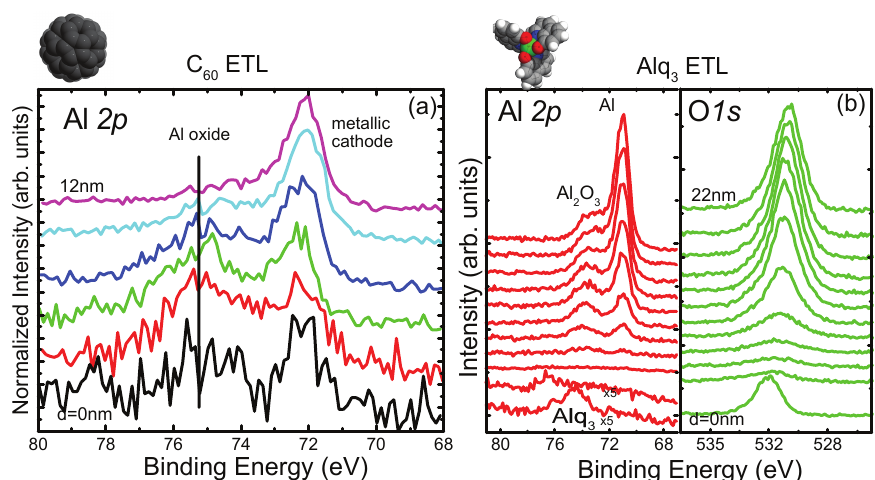
Figure 6. ( a ) XPS Al 2p core level for the sputter profile through the thickness of the LiF layer for peeled Al/10 nm LiF cathodes on C 60 based OLEDs, showing the evolution of the chemisorbed Al. Reproduced from Ref. [34] with permission of The Royal Society of Chemistry. ( b ) XPS depth profile on the Al/LiF side of peeled off interface with 20 nm LiF layer. The evolution of the Al 2p , and O 1s core level features is shown as a function of the distance from the interface. The presence of an Al oxide at the Al/LiF interface suggests diffusion of O through pinholes in the Al films. Such O diffusion ends abruptly at the Al/LiF interface. Adapted from Ref. [9] with the permission of AIP